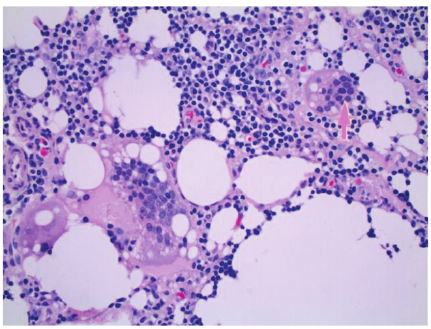
Figure 2: Inguinal lymph node excisional biopsy showing giant cells